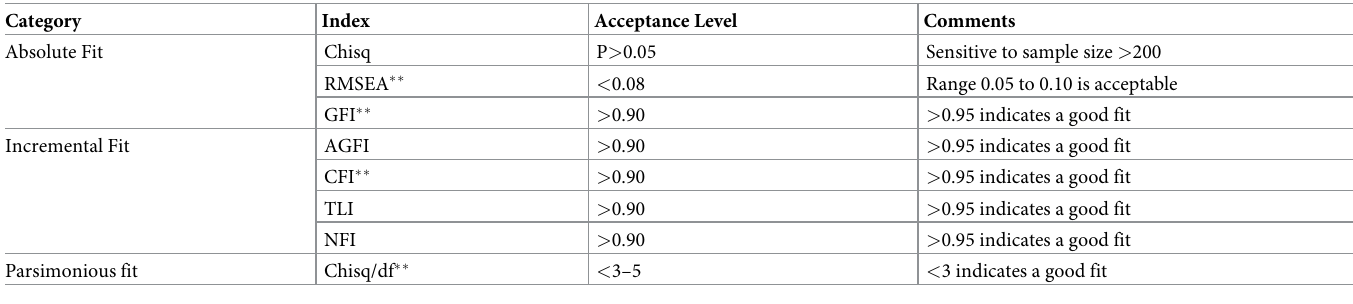
Table 6. Goodness-of-fit